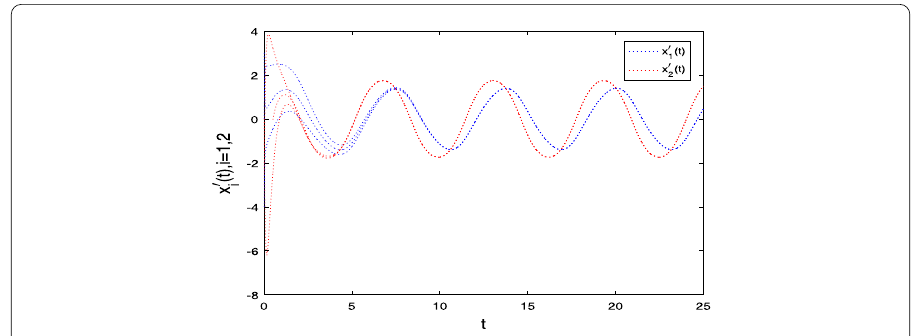
Figure 2 Numerical solutions x (cid:2) ( t ) to system (4.1) with initial value ( ϕ 1 ( s ), ϕ 2 ( s ), ψ 1 ( s ), ψ 2 ( s )) ≡ (2sin t + 1, –2cos t – 3,2,0),(2cos t + 2,3sin t – 1,0,3),(–3sin t – 2,–4sin t +